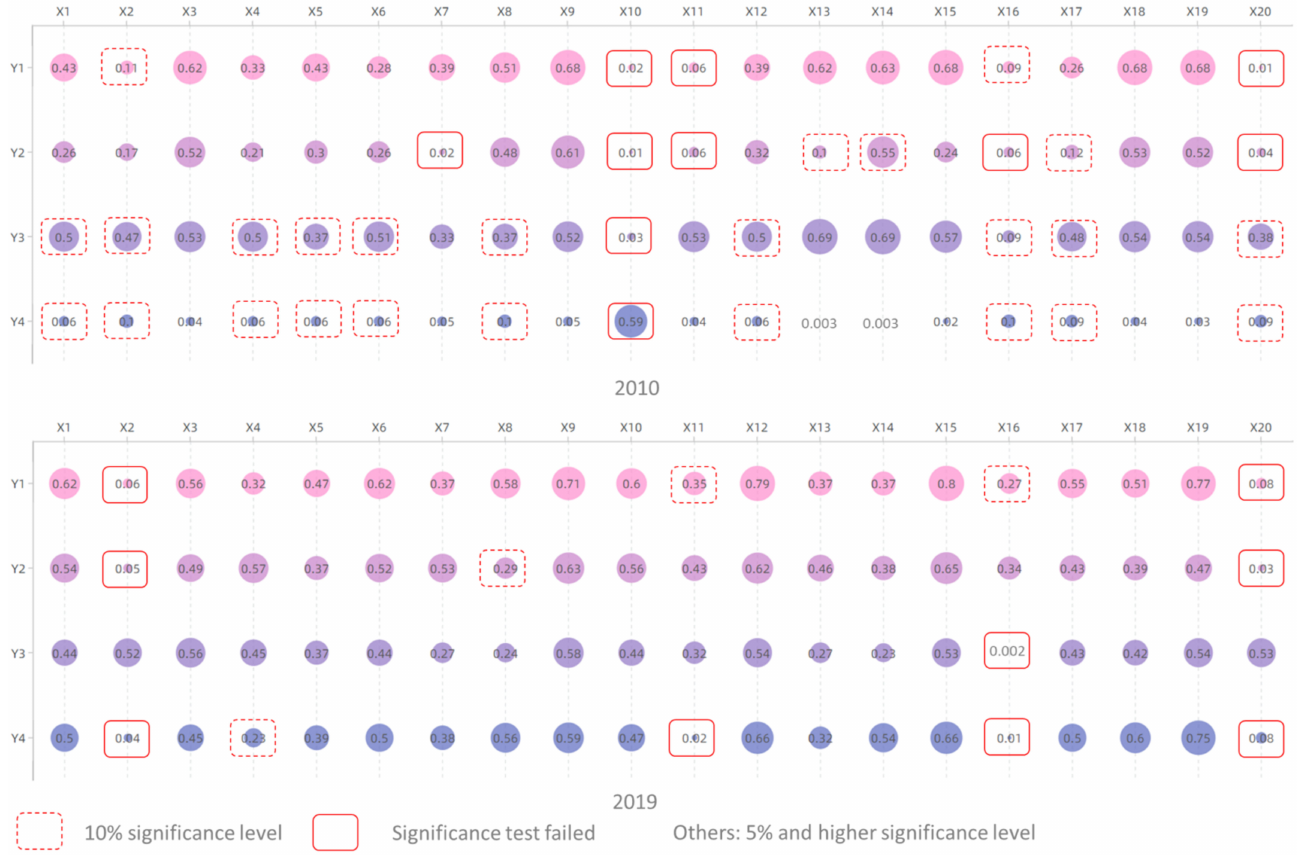
Figure 7. Analysis of factor